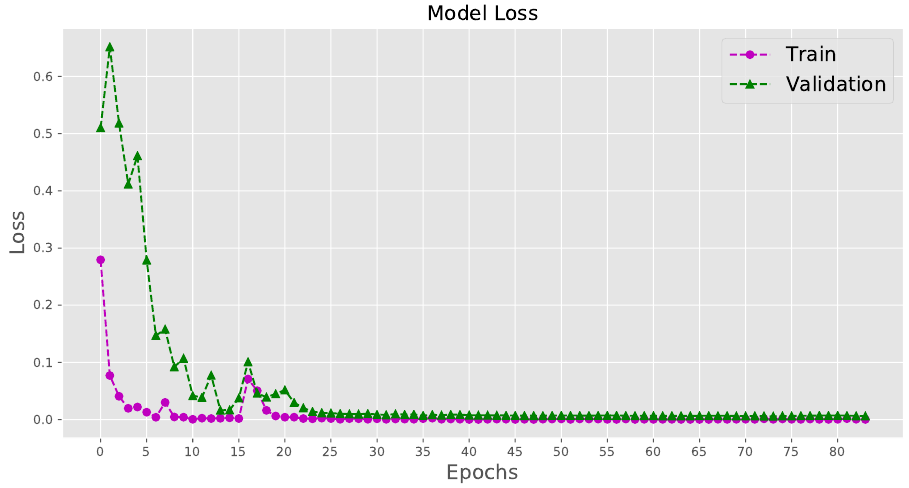
Figure 7. Visualizing the loss for the last fold cross-validation training. Table 5. Performance of the model in average of 5-fold cross-validation for both classes. Precision Recall F1-Score AUC